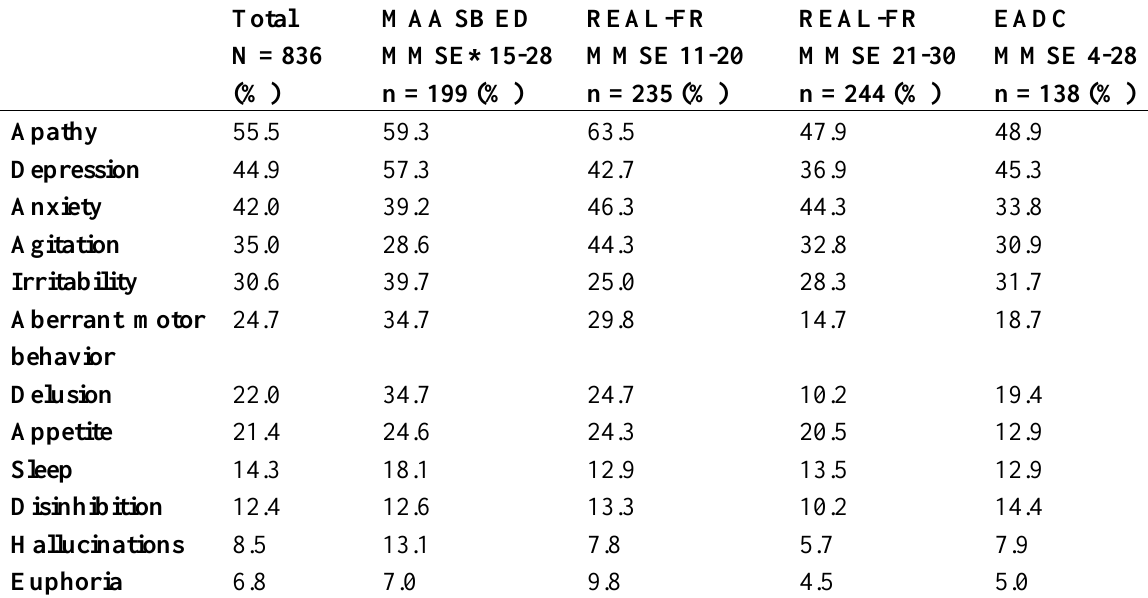
Table 1. Frequency of BPSD evaluated with the NPI in three European studies. MAASBED: Maastricht Study of Behavior in Dementia, REAL: Réseaux Alzheimer Français, EADC: European Alzheimer Disease